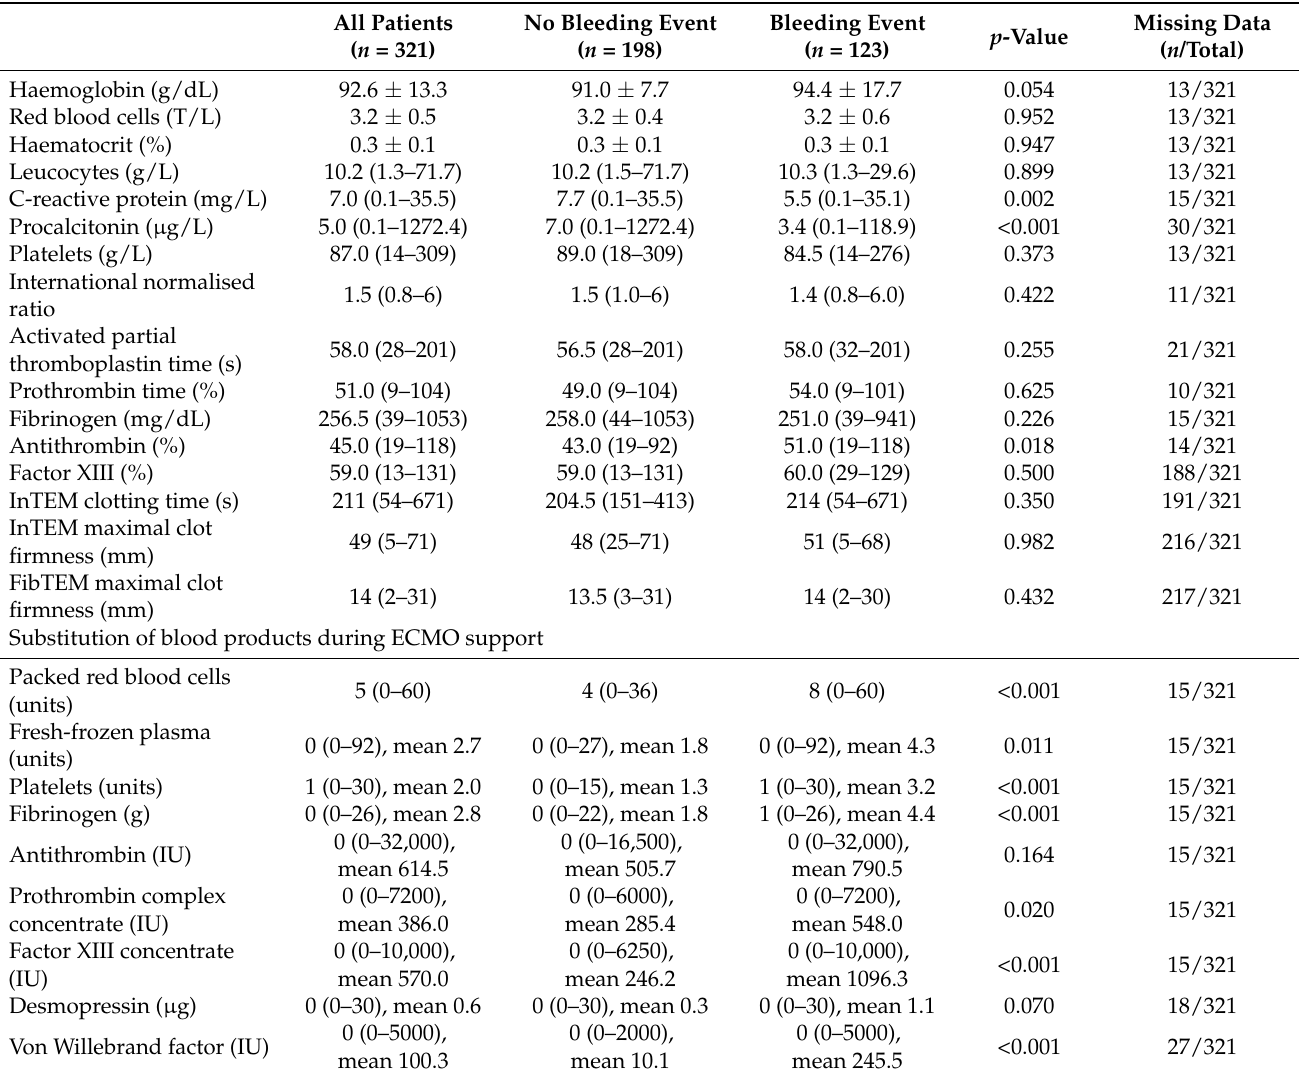
Table 3. Laboratory parameters within 24 h prior to bleeding event and blood products substitution during ECMO support ( n =